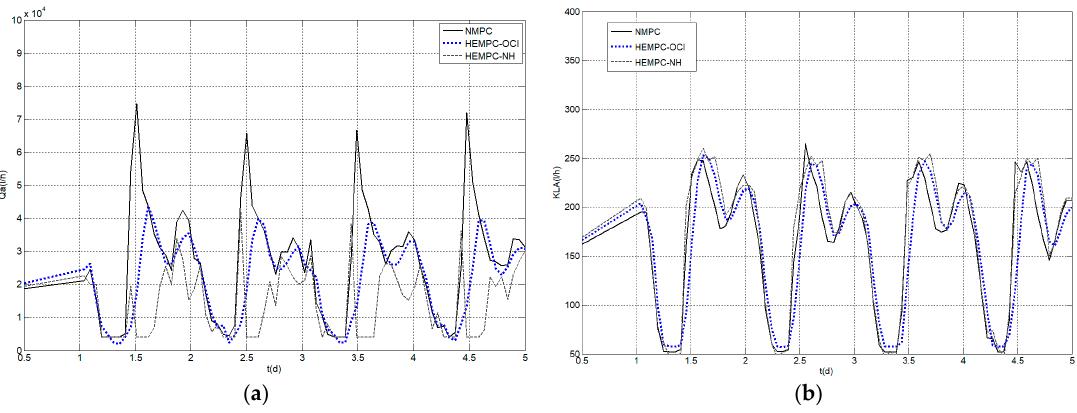
Figure 5. Control signals applied to the BSM1 plant operating under NMPC and HEMPC controllers.